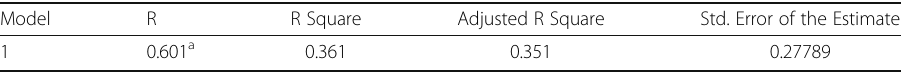
Table 3 Model Summary Model R